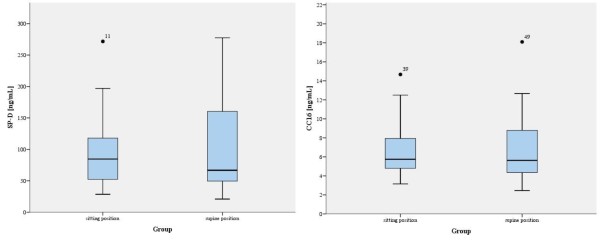
Surfactant protein D (SP-D) and Clara cell protein (CC16) concentration in patients undergoing surgery in the sitting and the supine positions. The horizontal line represents the median; the box encompasses 25th - 75th percentiles (the interquartile range, IQR), and the whiskers show upper and lower quartiles.